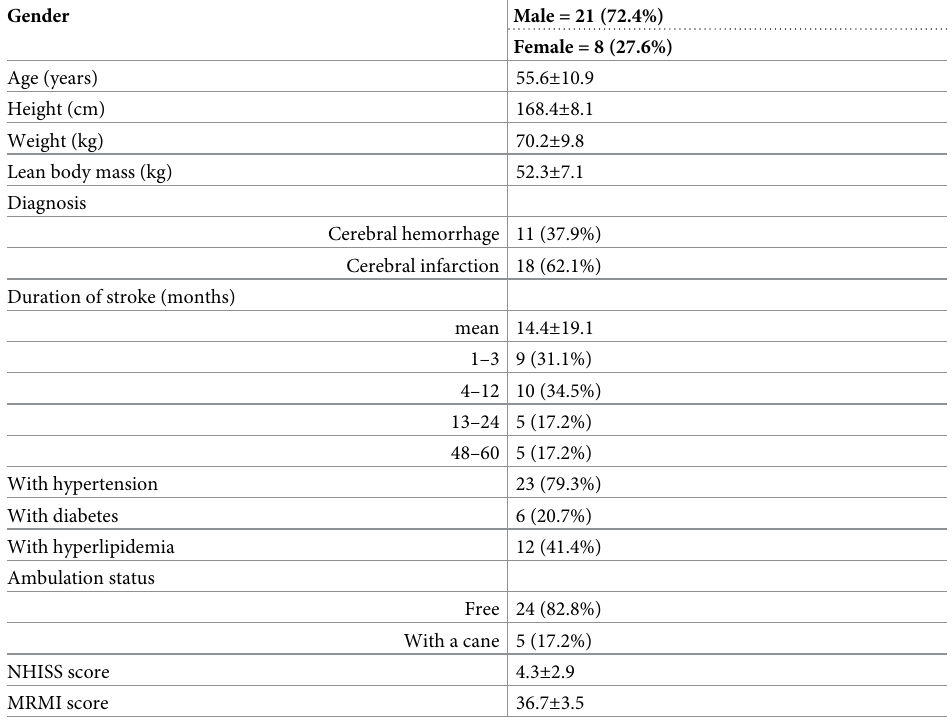
Table 1. Demographic data of the 29 participants. Data in n(%) or mean ±